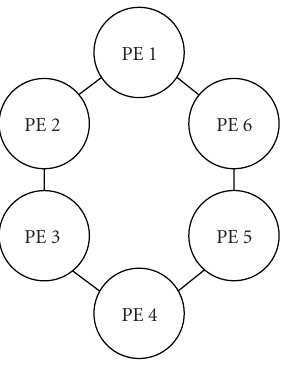
Figure 1: M = 6 processors in a ring configuration for parallel im- plementation of the local resampling